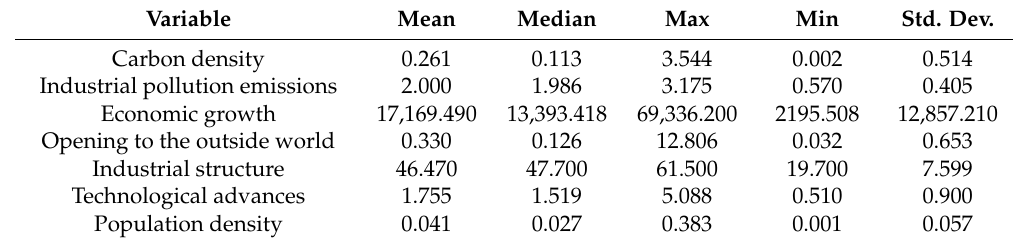
Table 2. Statistical description of all